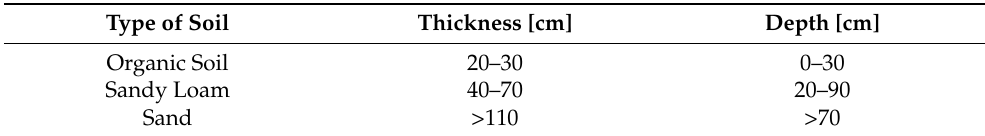
Table 1. Soil layers in the considered urban catchment area.